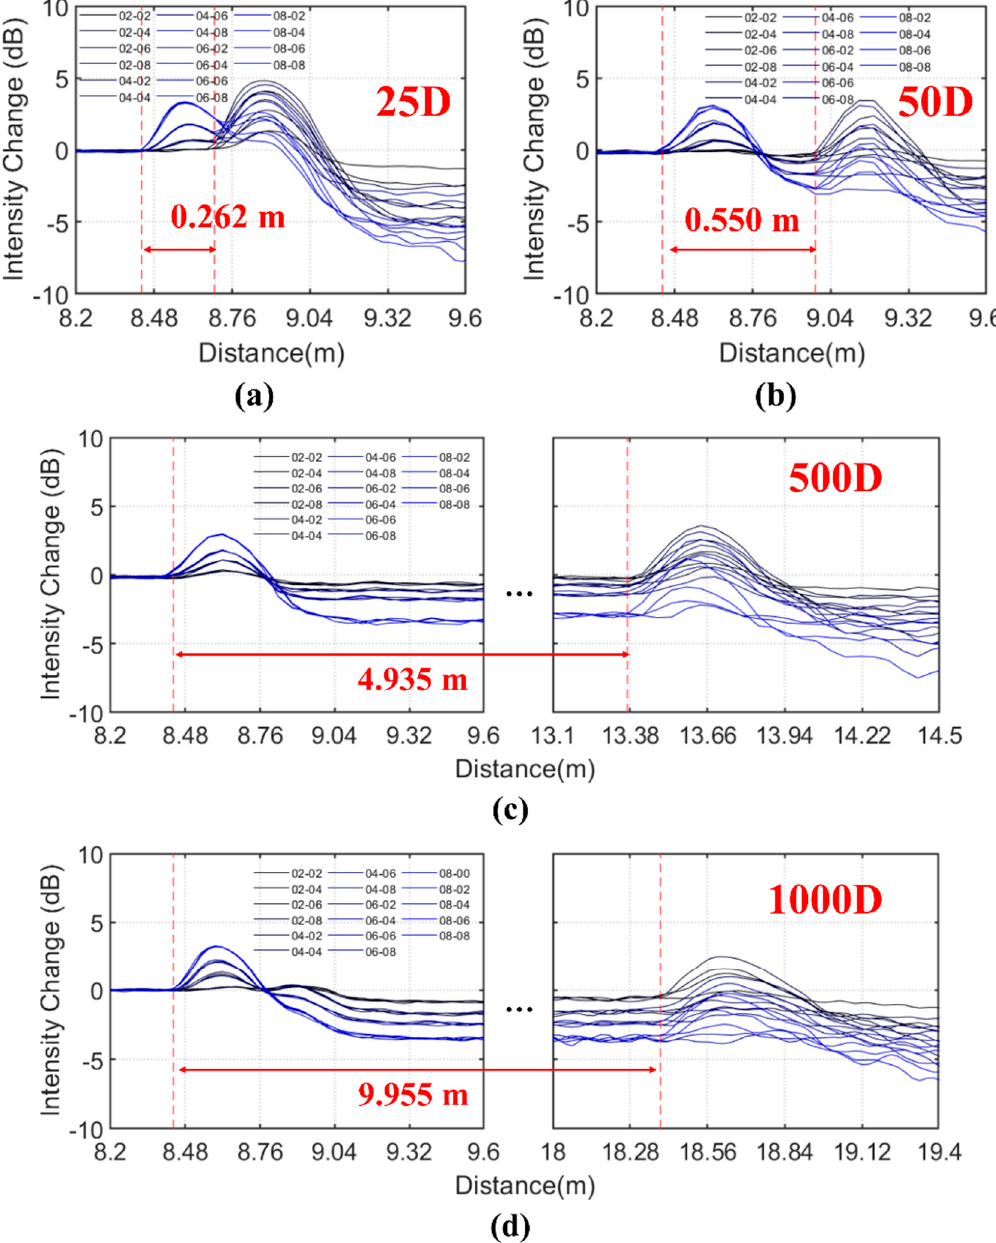
Figure 9. Intensity changes of double shear events with separation distances of ( a ) 25 cm, ( b ) 50 cm, ( c ) 500 cm, and ( d ) 1000 cm.